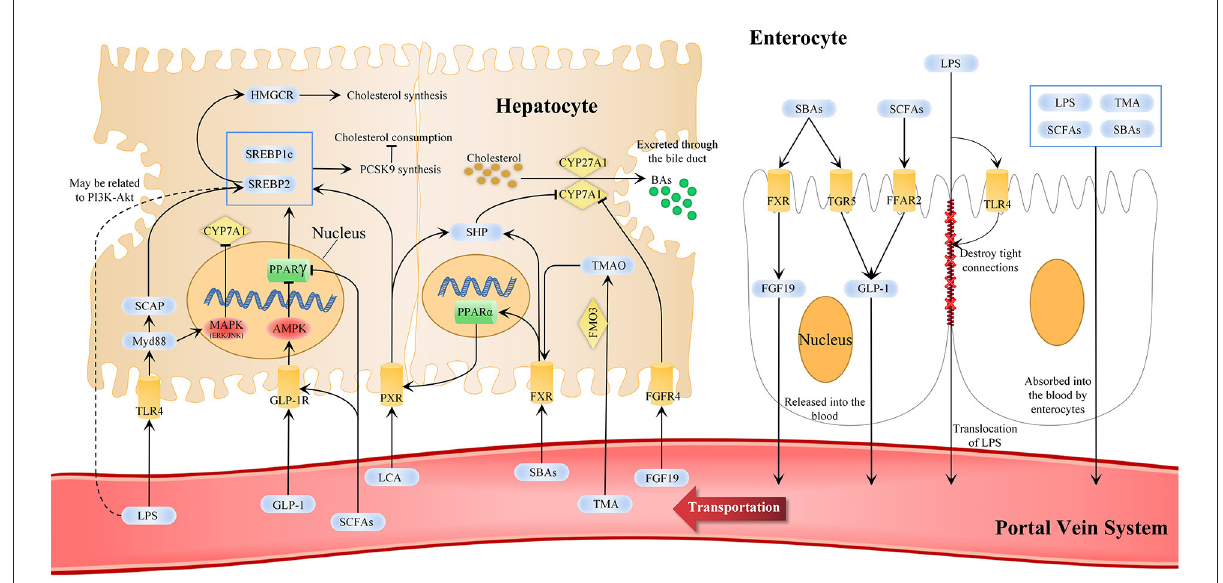
FIGURE2 Statins-related microbiota metabolism and pathways in cholesterol metabolisms. In cholesterol metabolism, changes in gut microbiota composition and its metabolites are markers for regulating the gut-liver axis and can reflect the effect of statins. The liver-gut axis can be used as one of the ways statins affect cholesterol metabolism and can explain the why the efficacy of statins differs individually. SCFAs, SBAs, TMA, LPS, and other MDMs are changed after statins administration. SCFAs and SBAs can activate enterocytes to secrete FGF19 and GLP-1 into the blood, and others are absorbed by enterocytes into the blood circulation and finally absorbed in the liver through the portal vein system. This affects the AMPK-PPAR γ -SREBP1C/2, FXR and TGR5 signaling pathways and LPS-TLR4-Myd88 and PI3K-Akt in hepatocytes to promote BAs excretion, reduce cholesterol synthesis and promote cholesterol consumption. AMPK, AMP-activated protein kinase; CYP7A1, cytochrome p-450 enzyme cholesterol 7 α -hydroxylase; CYP27A1, cytochrome p-450 enzyme cholesterol 27 α -hydroxylase; FXR, farnesoid X receptor; FGF 19, fibroblast growth factor 19; FGFR4, fibroblast growth factor receptor 4; GLP-1, glucagon-like peptide 1; GLP-1R, GLP-1 receptor; HMGCR, 3-hydroxy-3-methylglutaryl-CoA reductase; LPS, lipopolysaccharides; MAPK, mitogen-activated protein kinases; MDMs, microbiota-derived metabolites; Myd88, myeloid differentiation factor 88; PI3K-Akt, the phosphatidylinositol-3-kinase; PPAR, peroxisome proliferator-activated receptor γ ; SBAs, secondary bile acid; SCAP, SREBP cleavage-activating protein; SCFAs, short-chain fatty acid; SHP, FXR-small heterodimer partner; SREBP, sterol regulatory element binding protein; TGR5, cell surface receptor G protein-coupled bile acid receptor 5; TLR4, Toll-like receptor 4; TMA, trimethylamine; TMAO,